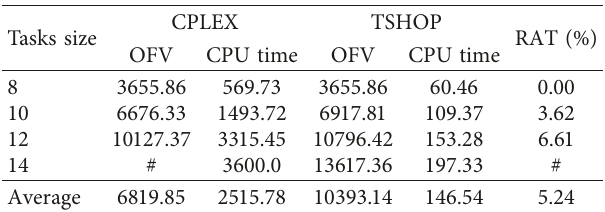
Table 6: Performance for CPLEX and TSHOP applied to small-size